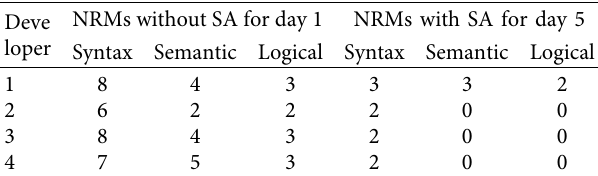
Table 9: Developers’ NRMs on days 1 and